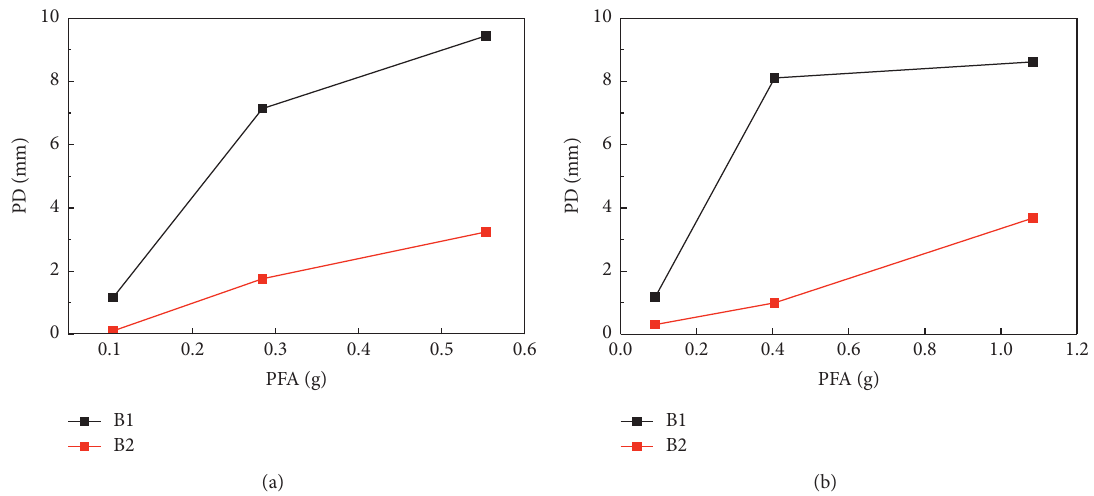
Figure 17: Peak displacement under sweep waves. (a) Response in X direction and (b) response in Y direction.